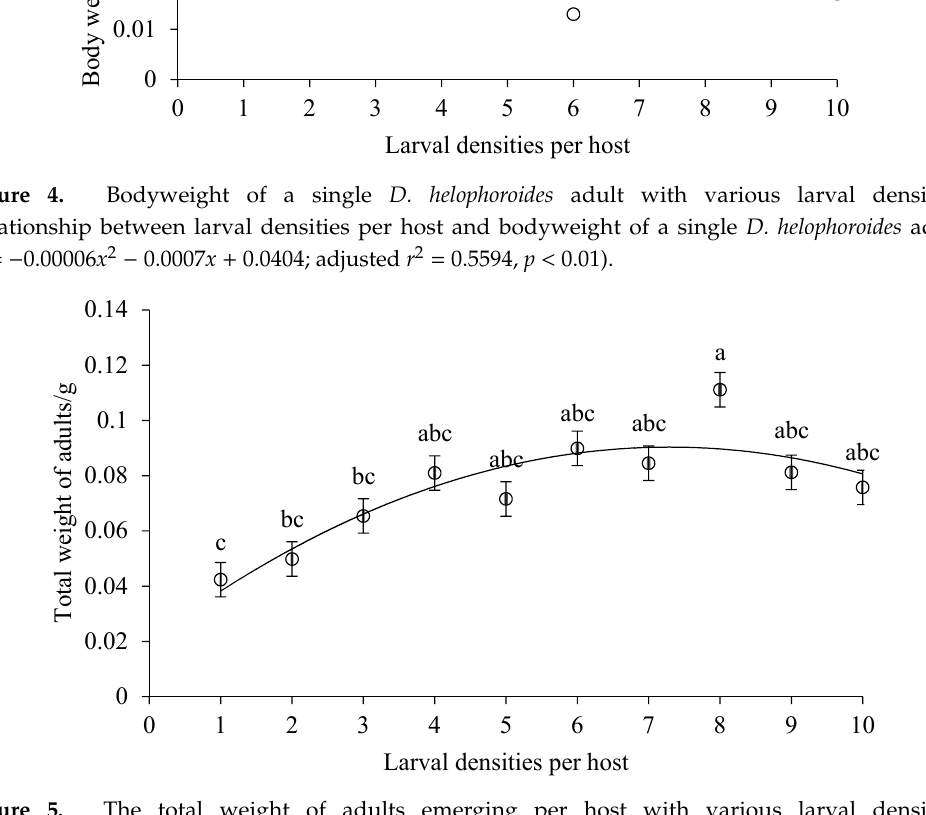
Figure 5. The total weight of adults emerging per host with various larval densities. Relationship between larval densities per host and the total weight of adults emerging per host ( y = − 0.0013 x 2 + 0.0192 x + 0.0203; adjusted r 2 = 0.7874, p < 0.01). See Figure 1 legend for interpretation.